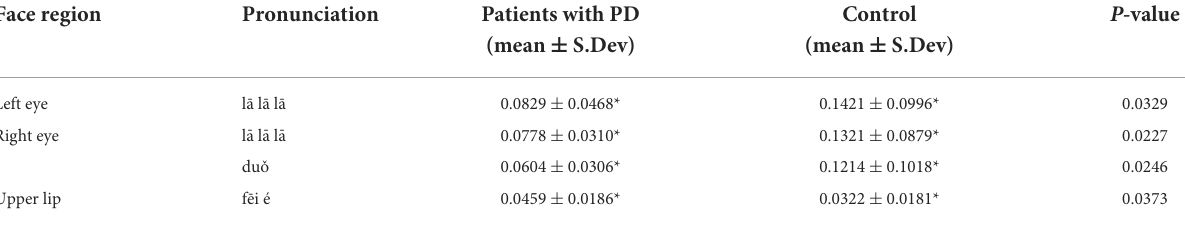
TABLE 3 Comparison of face regions in groups, based on syllable